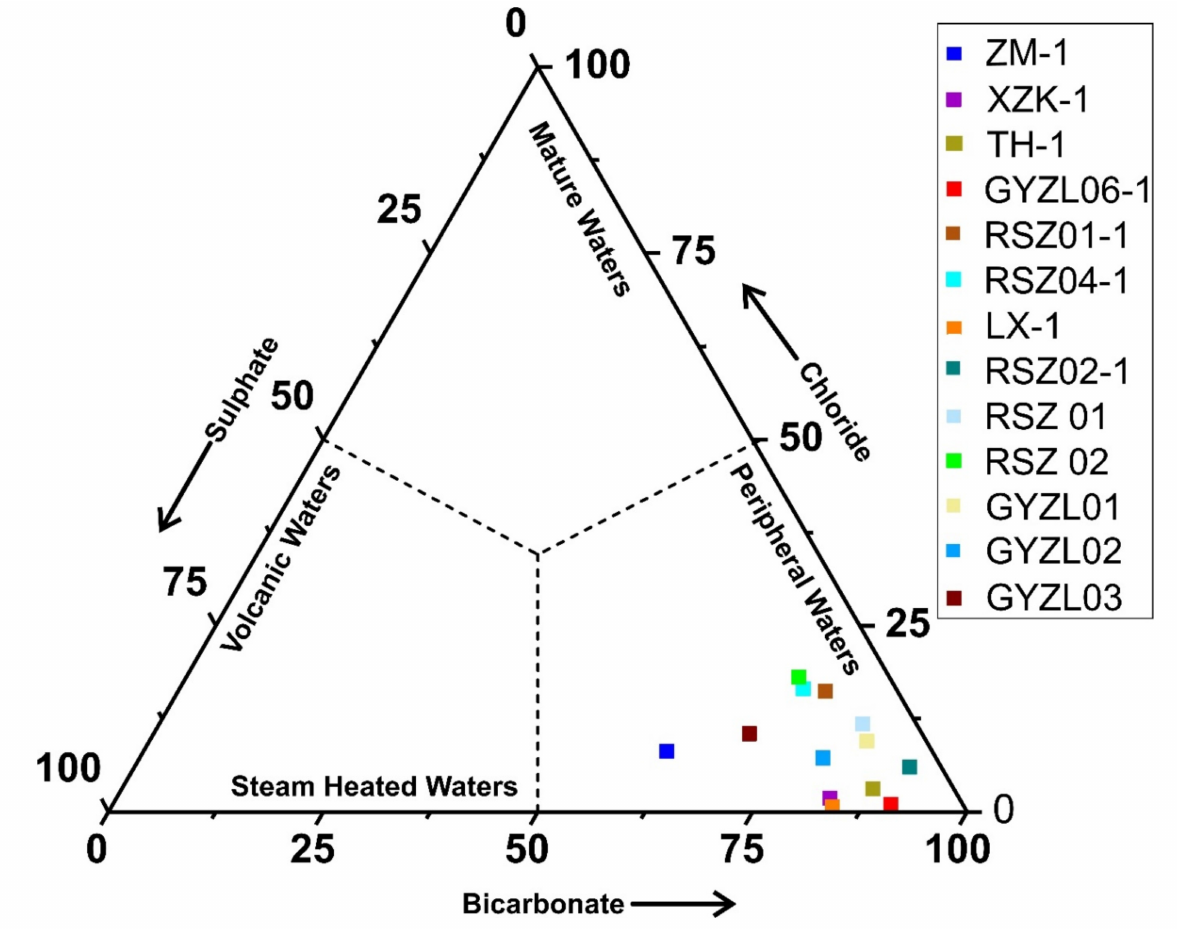
Figure 8. Relative Cl-SO 4 -HCO 3 ternary plot showing all the water samples located at bicarbonate corner exhibit “peripheral water” type consisting mainly of HCO 3 −